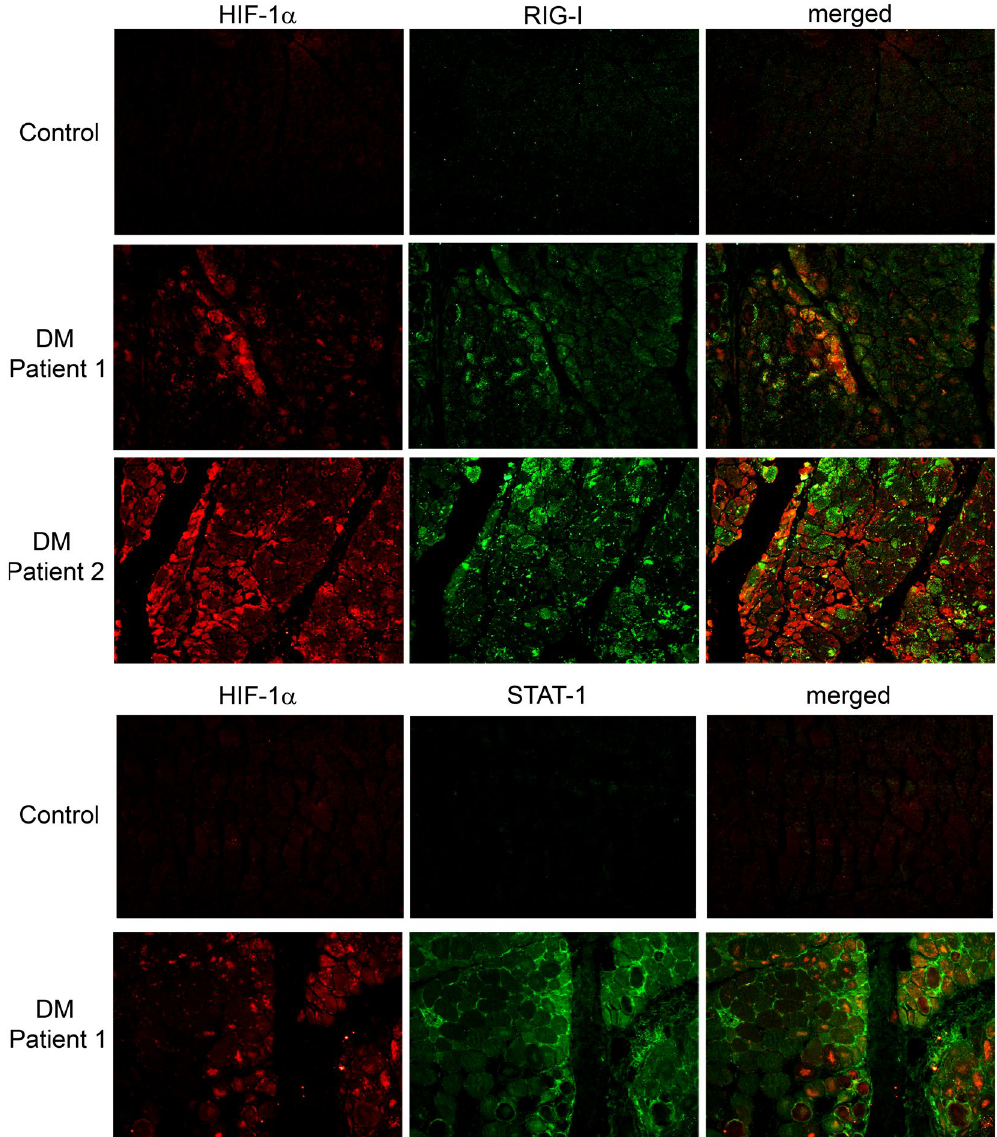
Figure 6. HIF-1 α is overexpressed in muscle biopsies from DM patients. Double immunofluorescence show that HIF-1 α is present mostly in perifascicular atrophic fibres and some of them are also positive for RIG-I and STAT1. Control muscle biopsies are negative for HIF-1 α , RIG-I and STAT1. Magnification ×